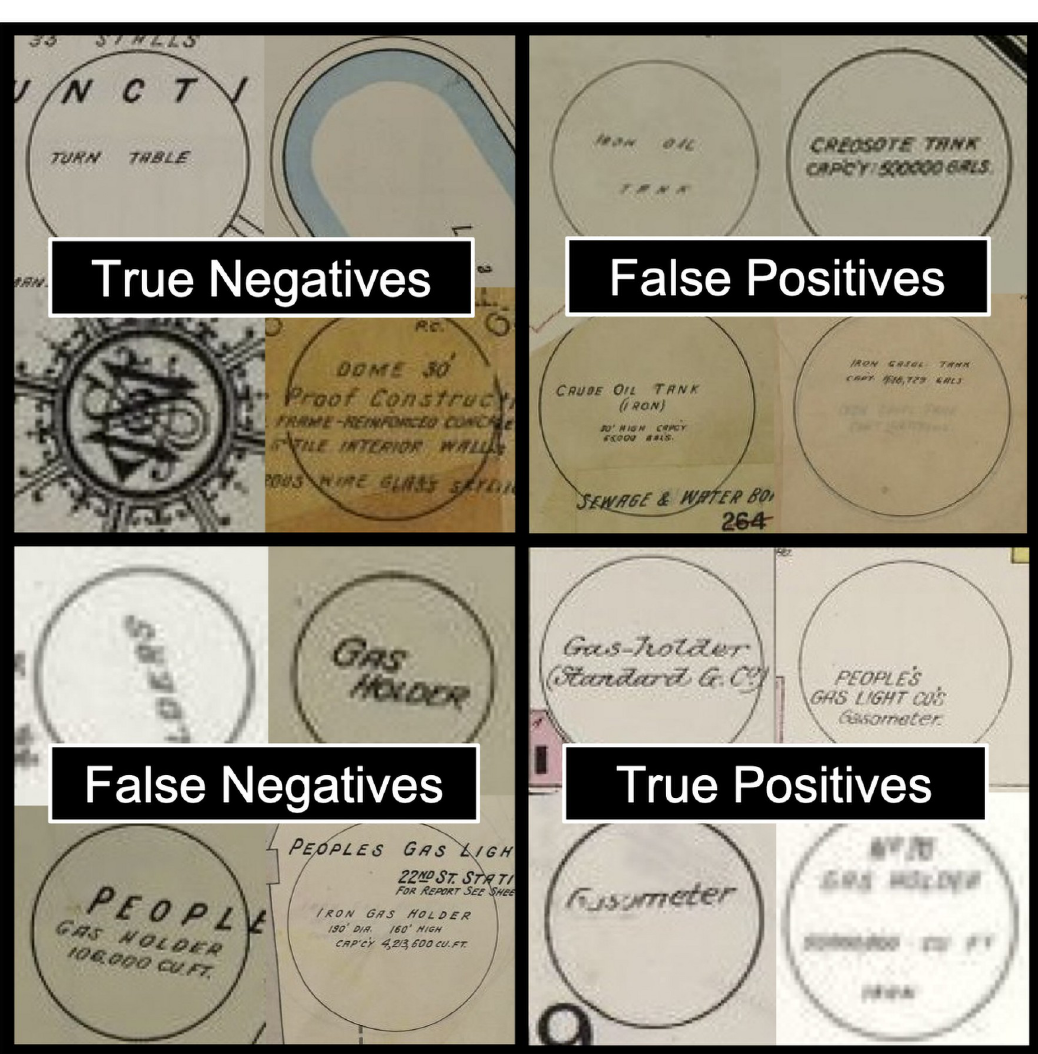
Fig 3. Examples of positive and negative MGP classification categories. Fig source: Tollefson, using map images from Sanborn Map Company.